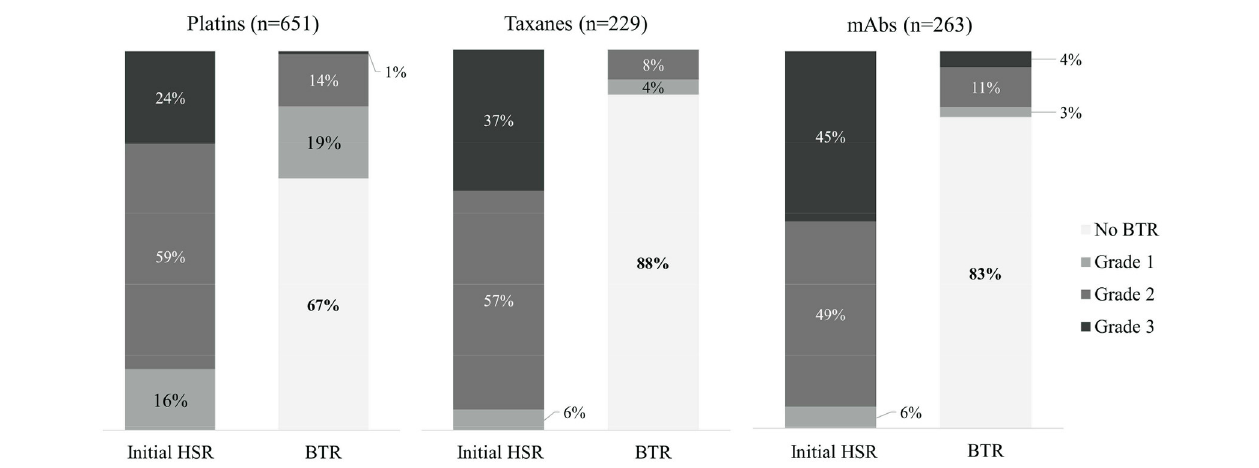
FIGURE 1 | The comparison of severity of initial HSRs and BTRs in each drug type. mAbs, monoclonal antibodies; HSR, hypersensitivity reaction; BTR, breakthrough reaction.